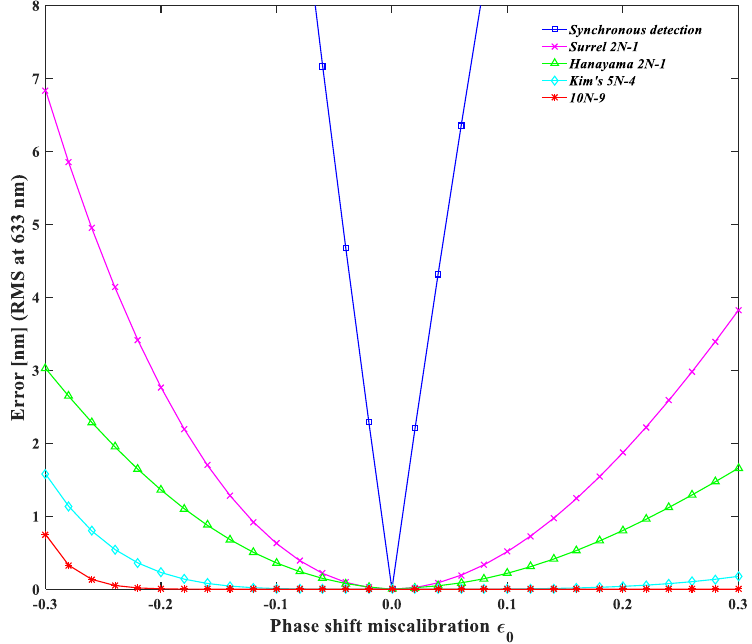
Figure 7. RMS error as a function of phase shift miscalibration ( r 1 = 4%, r 2 = 30%).